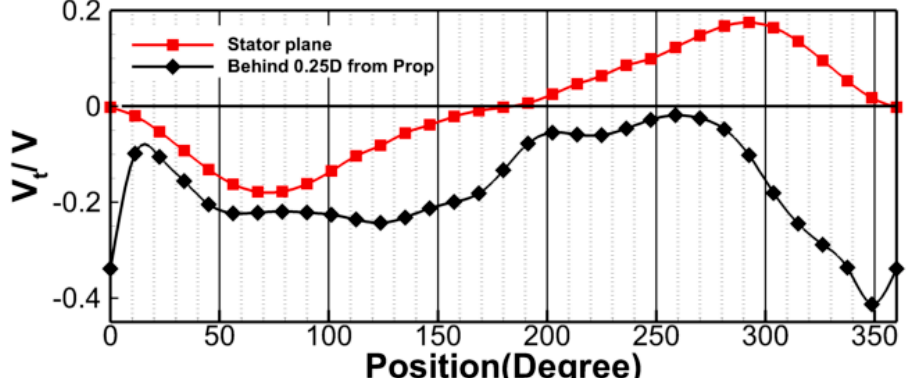
Figure 11. Averaged circumferential tangential velocity at stator plane and the plane behind 0.25 D from propeller (with propeller, without stator).